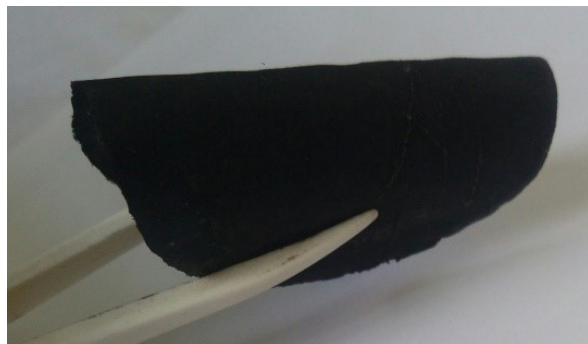
Figure 6: Photograph showing the elasticity of the three-phase conducting polymer